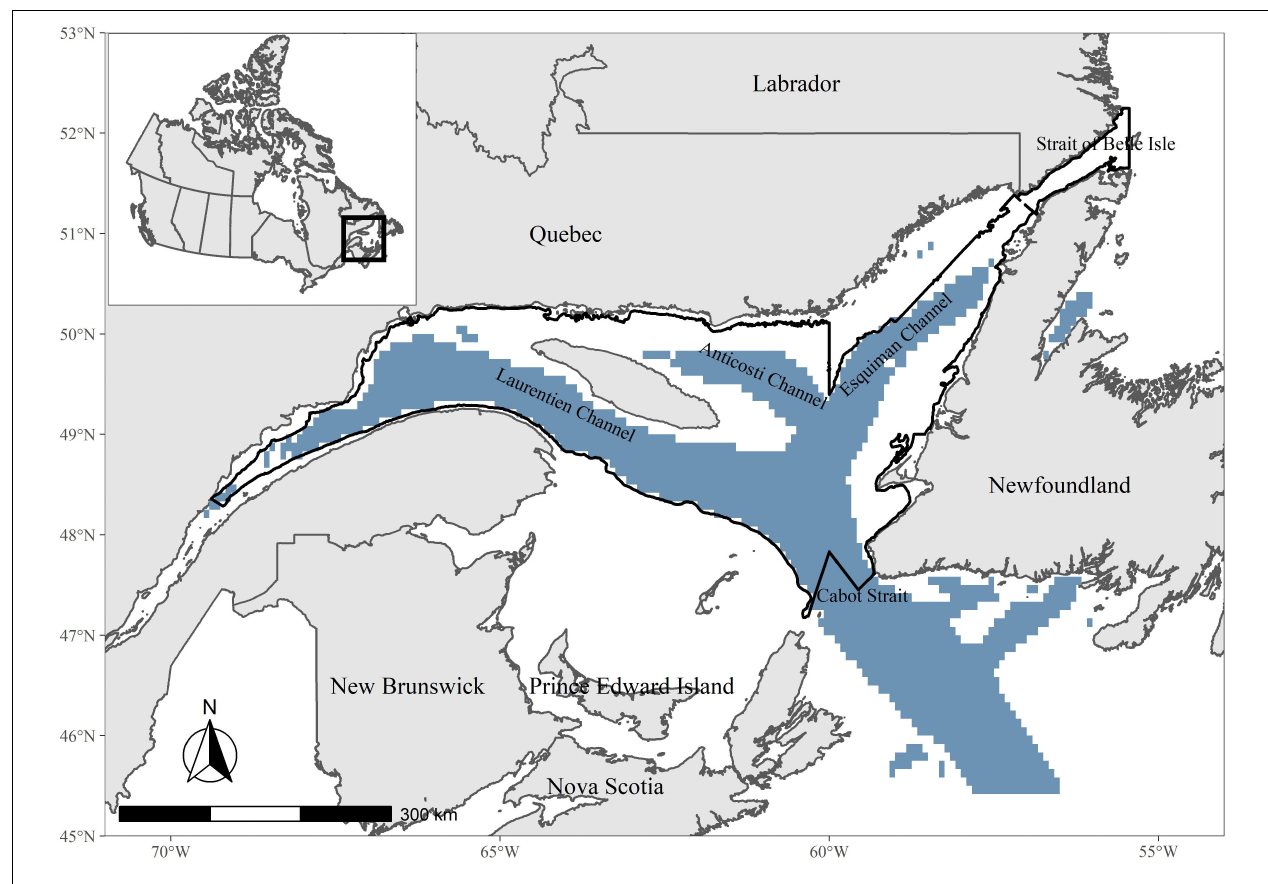
FIGURE 1 | Location of sampling sites for years 2011–2018 covering the Estuary and Gulf of St. Lawrence (EGSL). Deep channels are shown in blue (depth > 200 m). The study area is indicated by the black